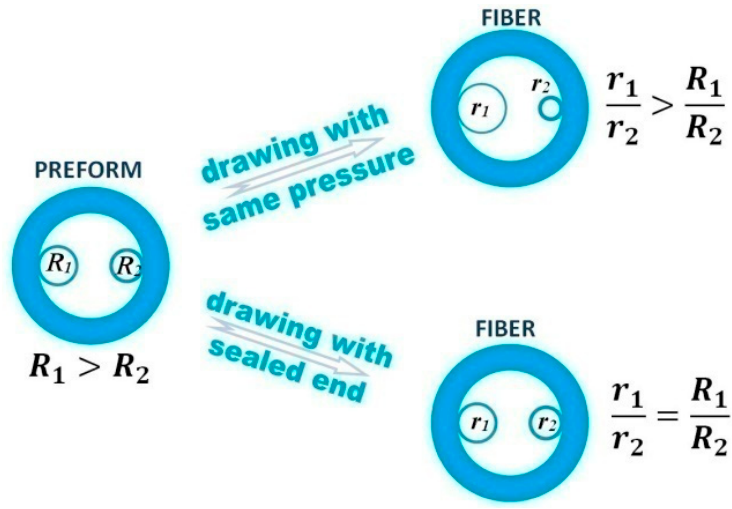
Figure 8. The scheme of RF drawing. Drawing with same pressure in all capillaries (on the top), drawing with sealed end (on the bottom).